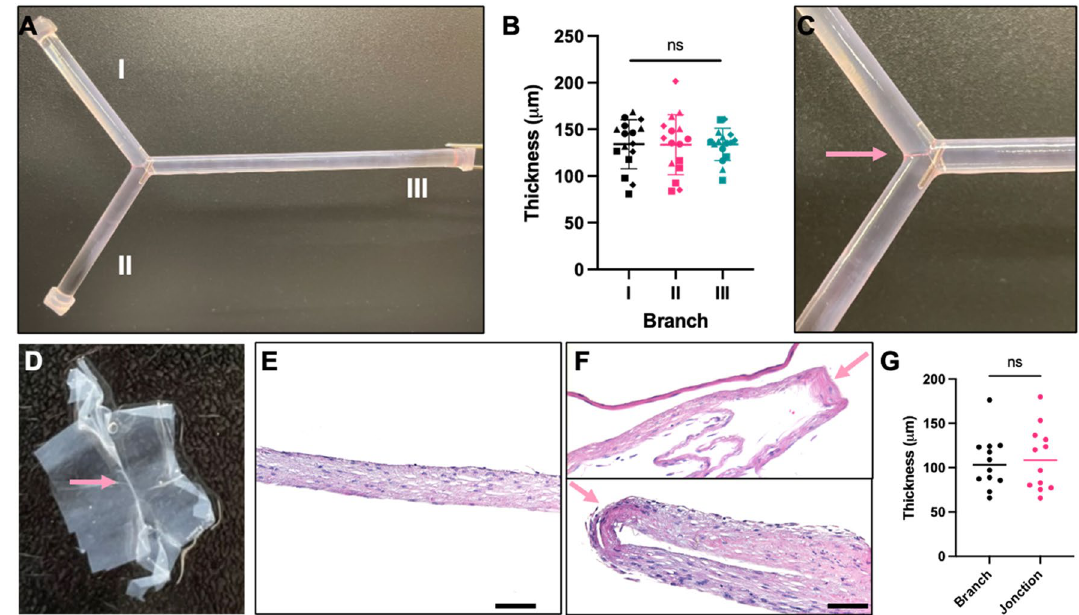
Figure 5. Macroscopic and microscopic characterization of the branched TEBV-A produced with the developed rotary seeding system. ( A ) Photograph of a “Y” geometry TEBV-A on a branched PETG scaffold; ( B ) tissue thickness of the three branches (I, II, III) of TEBV-A in µm. N = 4, n = 4; ( C ) close-up photograph of TEBV-A junction on the scaffold ( D ) and cut off from the scaffold; ( E ) H&E staining of the branch and ( F ) junction of TEBV-A sample cut off from the scaffold; ( G ) Tissue thickness of histological sections of the branches and the junction of TEBV-A in µm. n = 12. Arrows show junction site. For statistical analyses, a Kruskal–Wallis test with Dunn’s multiple comparison test was performed for graph ( B) and a Welch’s t-test for graph ( G ). Graph ( B,G ) shows scatter plot with bars and standard deviation. Scale bar = 100 µm. ns non-